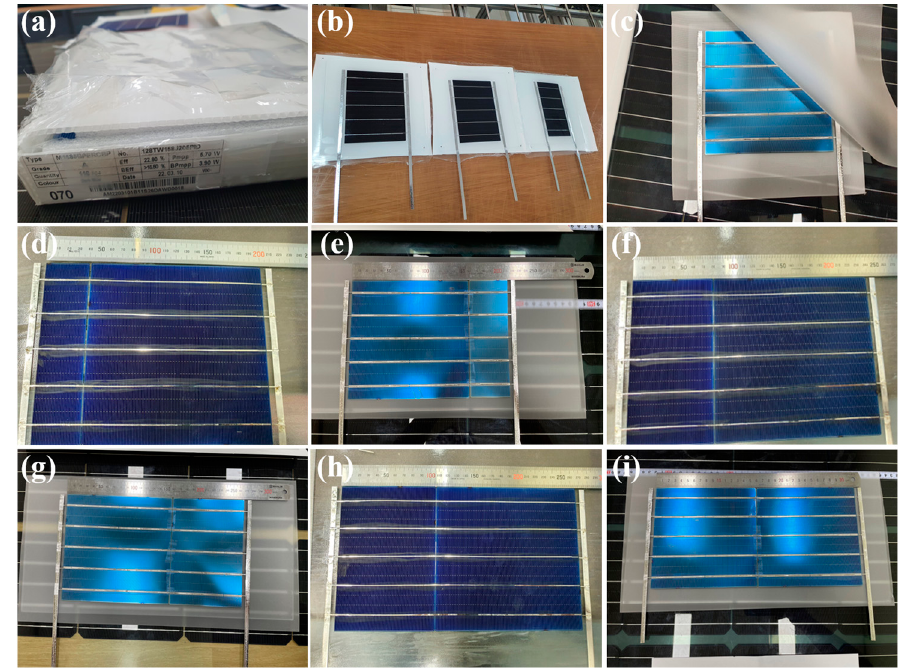
Figure 6. Fabrication of unit module samples with various output deviations.